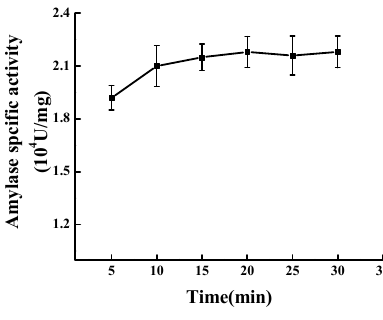
Figure 5. Effect of modification time on modification.